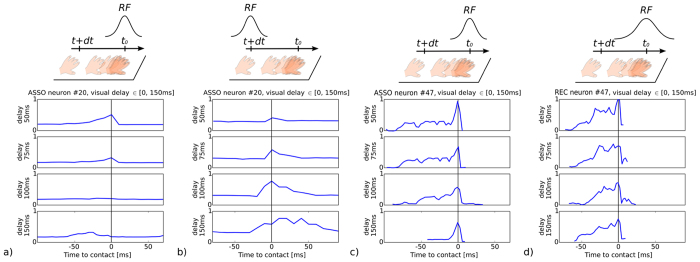
Visual delay sensitivity of one neuron in the associative map in conditions of spatially non-contiguous and contiguous visuo-tactile signals; (a) and (b), respectively. Comparison between visual delay sensitivity of one neuron in the associative map and in the recurrent map; (c) and (d). Adding a temporal delay gives different neural activities whether or not the visuo-tactile receptive fields coincide. In the case of a spatial mismatch of the visuo-tactile receptive fields as in (a), the neuron activity decreases, cancelling the perception of contingency. In the case of a spatial overlap of the visuo-tactile receptive fields as in (b), the neuron activity increases, giving the illusion of contingency. Besides, the recurrent neuron in (d) is more robust to delays than the asso neurons in (c).